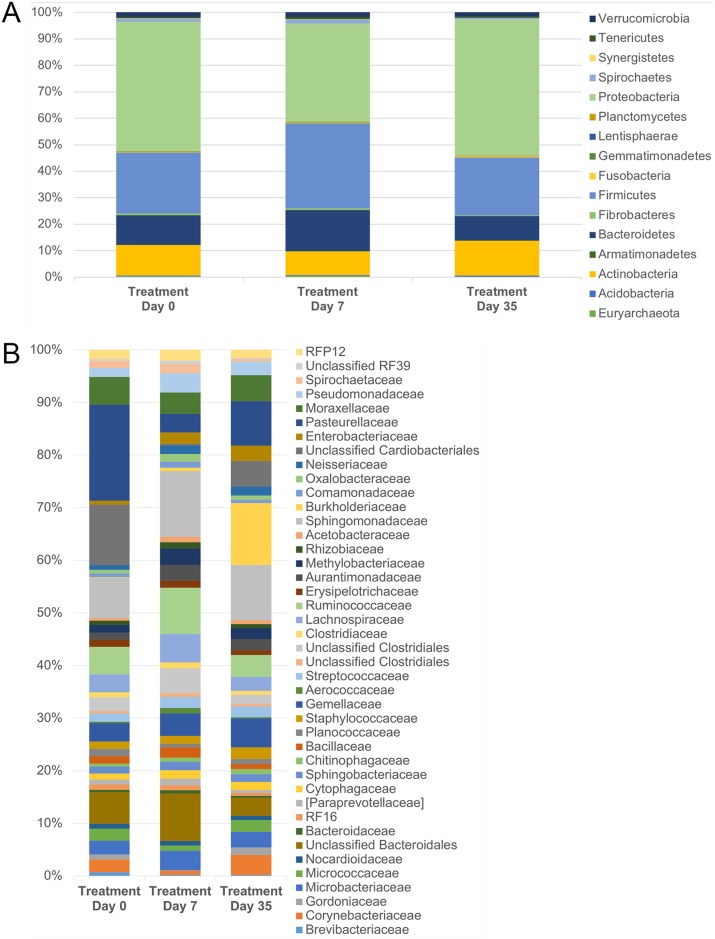
Temporal composition by bacterial phyla (A) and families (B) in treated eyes. Data are presented at baseline (day 0), day 7, and day 35.The bars represent mean percentage of sequences, totaling 100% at each time point.